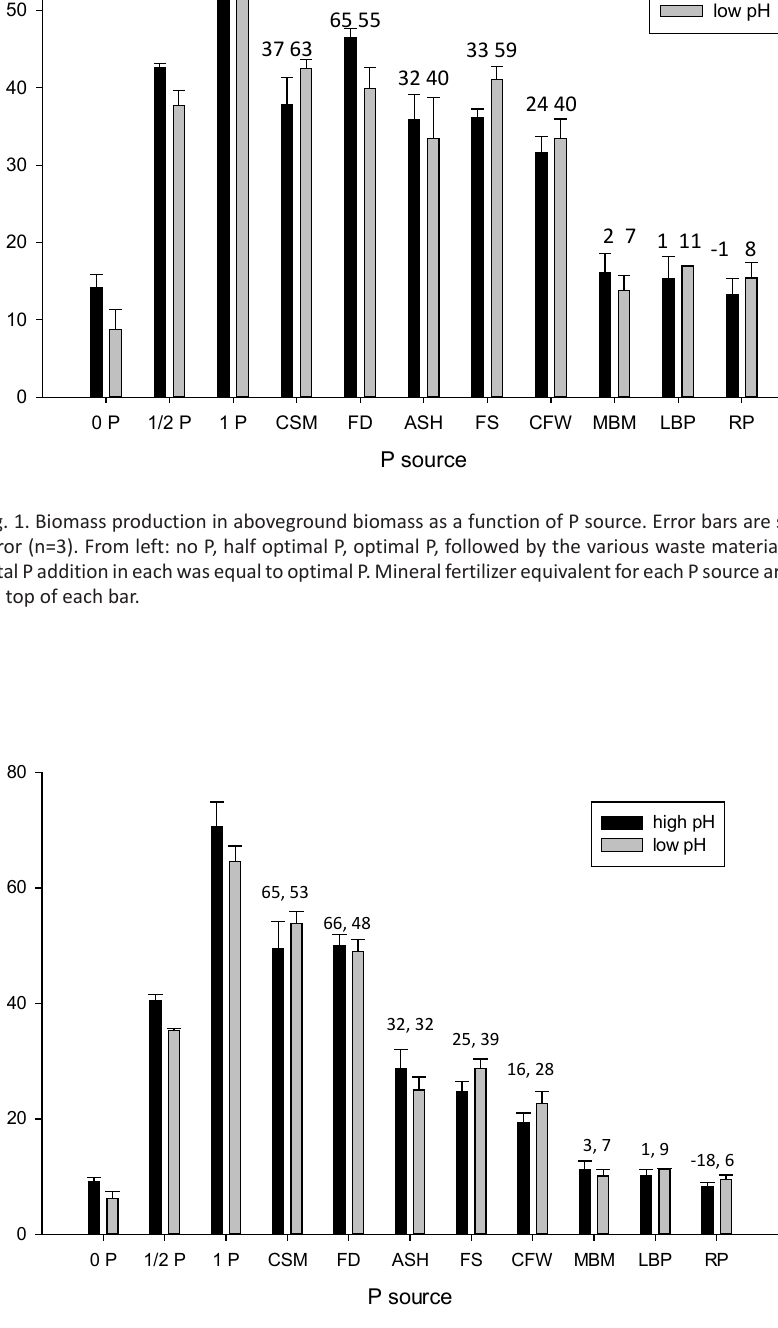
Fig. 2. Total P uptake in aboveground biomass as a function of P source. Error bars are standard error (n=3). From left: no P, half optimal P, optimal P, followed by the various waste materials where total P addition in each was equal to optimal P. Mineral fertilizer equivalent for each P source are shown on top of each